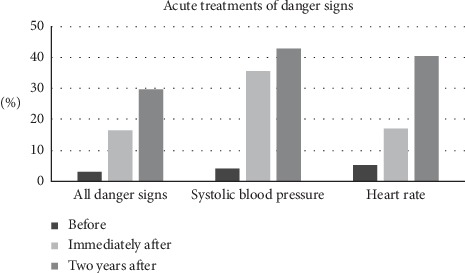
Acute treatments of danger signs. Proportion of danger signs that were followed by an acute treatment according to the Vital Signs Directed Therapy Protocol before implementation, immediately after implementation [12], and two years after implementation (shown for all danger signs combined and for the systolic blood pressure danger sign and heart rate danger sign separately).